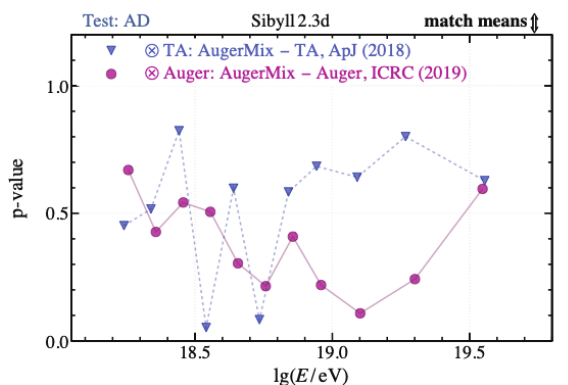
Figure 6. p -values from Anderson-Darling comparisons after removing di ff erences in mean between TA and Auger ⊗ TA X max distributions and between Auger and the AugerMix distributions, and smearing the Auger ⊗ TA X max distributions by an additional 18.9 g / cm 2